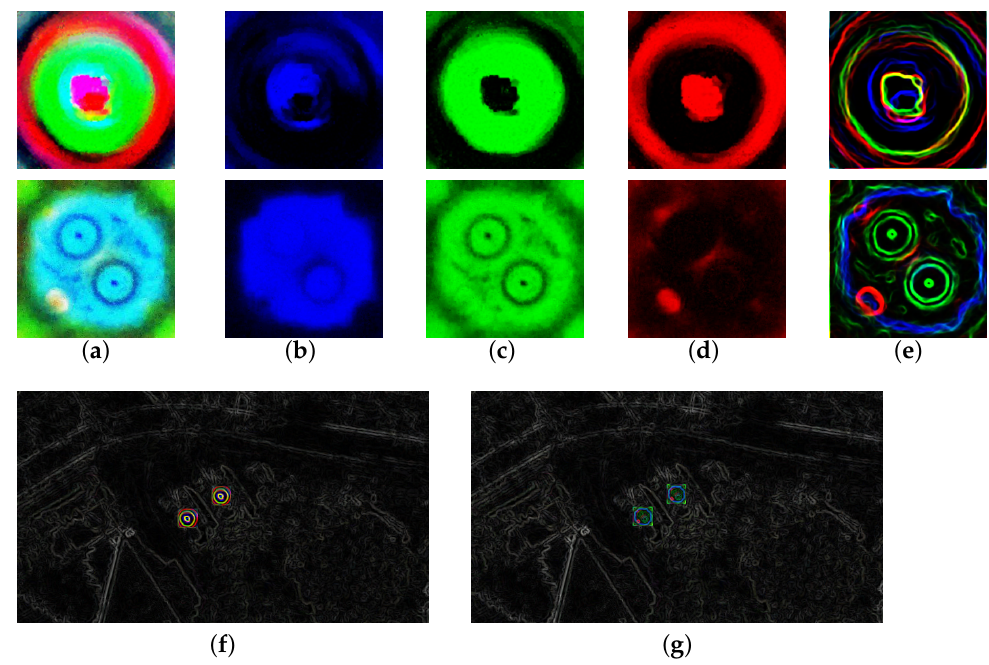
Figure 2. The original adversarial patch and its corresponding RGB channel image and gradient image: ( a ) original image; ( b ) blue channel; ( c ) green channel; ( d ) red channel; ( e ) gradient image. ( f , g ): the gradient image of the adversarial patch in the real